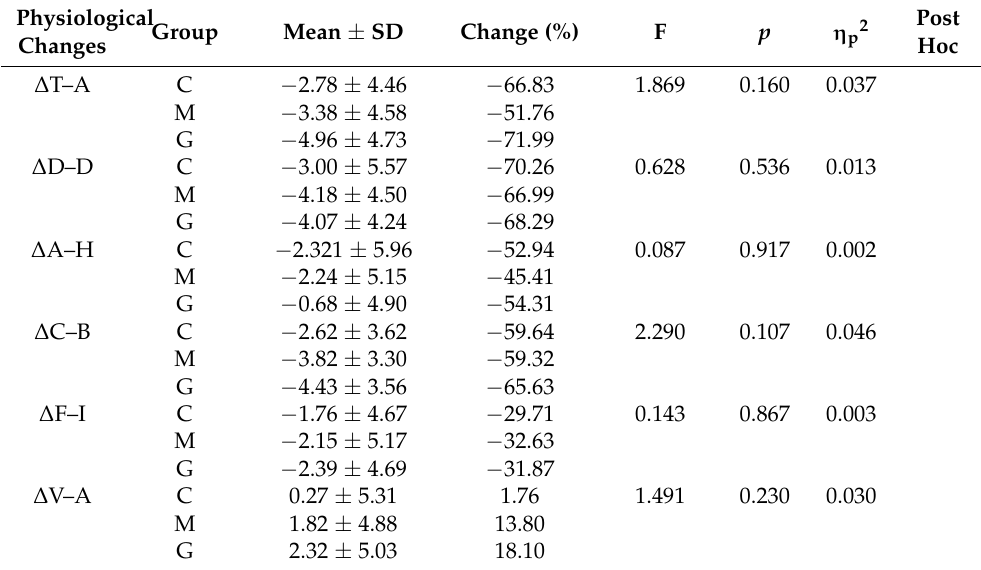
Table 8. Differences of mood state change scores among the three programs.